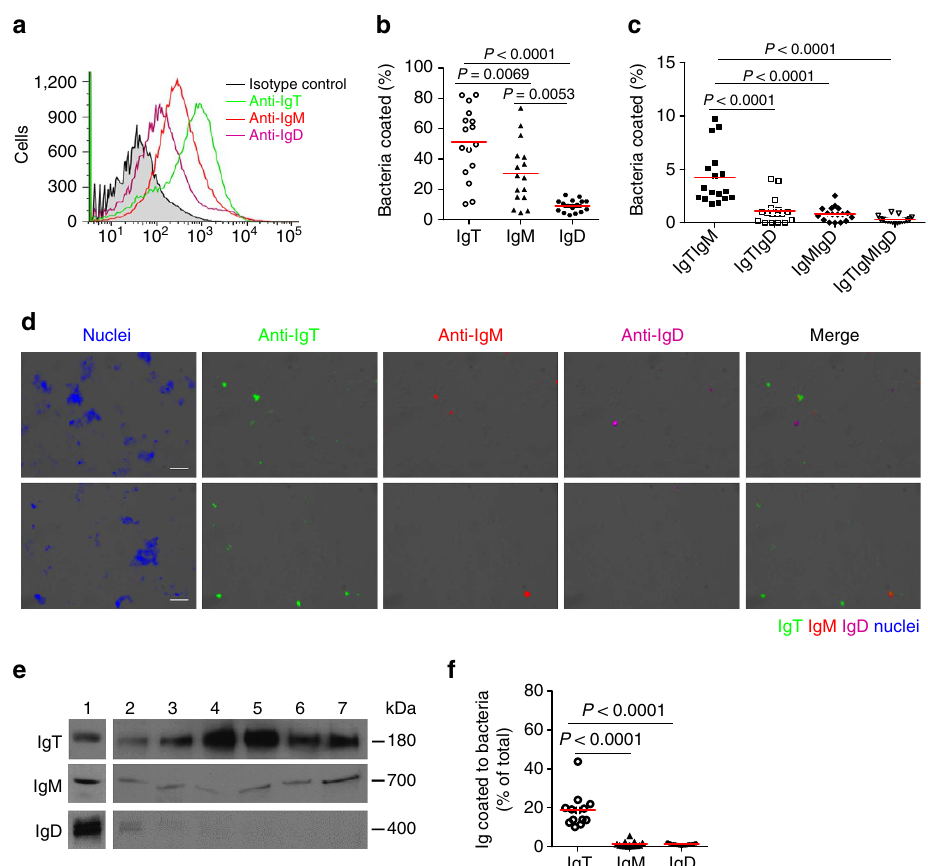
Figure 2 | Trout gill bacteria are predominantly coated with IgT. ( a ) Representative flow cytometry histograms showing the staining of gill bacteria with IgT, IgM and IgD. Bacteria were stained with anti-trout IgT (green line), anti-trout IgM (red line) or anti-trout IgD (magenta line) mAbs or isotype controls (shaded histograms). ( b , c ) Percentage of gill bacteria coated with IgT, IgM or IgD ( b ) or coated with IgTand IgM, IgTand IgD, IgM and IgD, IgTand IgM and IgD ( n ¼ 16) ( c ). The median percentage is shown by a red line. Statistical differences were evaluated by the nonparametric Mann–Whitney test. ( d ) Differential interference contrast (DIC) images of gill bacteria stained with a DAPI-Hoeschst solution (blue), anti-IgT (green), anti-IgM (red) or anti-IgD (magenta), and merging IgT, IgM and IgD stainings (Merge). (Isotype-matched control antibody staining is shown in Supplementary Fig. 3 online). (Scale bars, 5 m m). ( e ) Immunoblot analysis of IgT, IgM and IgD on gill bacteria. Lane 1, 0.1 m g of purified IgT, IgM or IgD; lanes 2–7, gill bacteria ( n ¼ 6 fish). ( f ) way ANOVA with Bonferroni correction. Data are representative of at least three independent experiments. ANOVA, analysis of